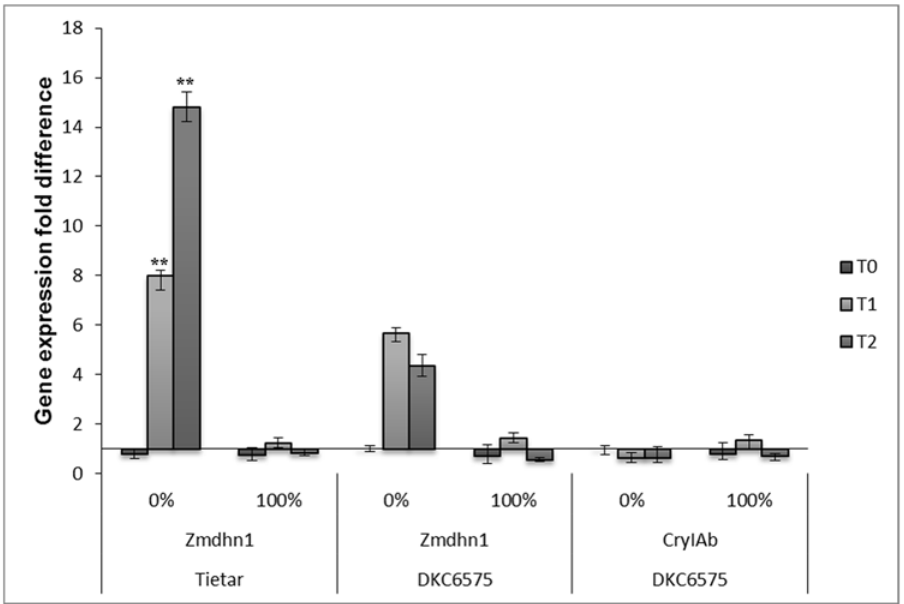
Fig 5. Time course of Zmdhn1 and CryIAb transcription evaluated by qRT-PCR in samples from the Field experiment. Samples of leaves were collected from plants in the Field experiment at the vegetative six- leaves stage (V6) (T0 stage), at the vegetative eight-leaves stage (V8) (T1 stage) and at silking (R1) (T2 stage), all at the same hour of day. 0% plants not irrigated from V6 stage to harvest; 100% plants fully irrigated (control). Relative quantification of gene expression is based on the 2 - ΔΔ Ct method using Zmabp3 as reference gene. Samples are a pool of four plants that were examined in triplicate. Each value is the mean +/- SD. ** indicate a significant difference at p < 0.01 evaluated by